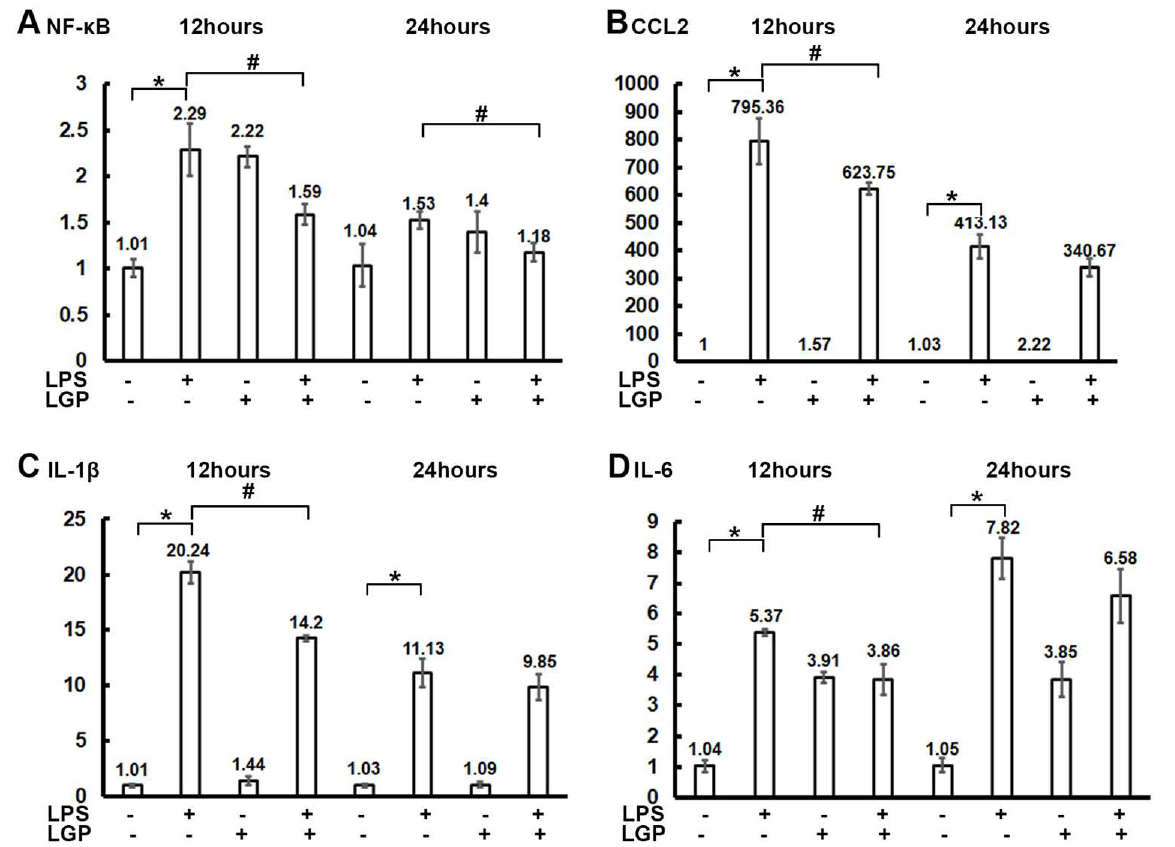
Figure 2. Quantitative real-time polymerase chain reaction (RT-qPCR) of NRK-52E cells after 12 or 24 h incubation with/without 10 μg/mL lipopolysaccharide (LPS) or 0.1 μg/mL linagliptin (LGP). The quantification results of